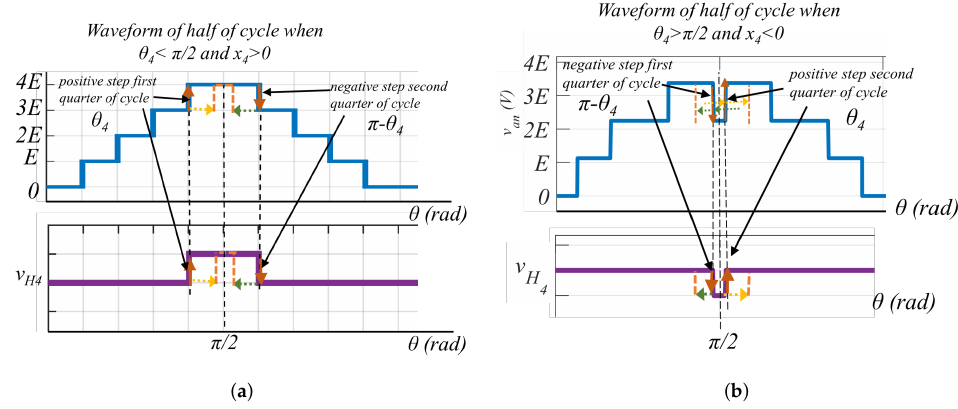
Figure 3. Waveforms of v an and v H 4 , shifting x 4 ( a ) for x 4 > 0 and θ 4 < π /2, ( b ) for x 4 > 0 and θ 4 < π /2.